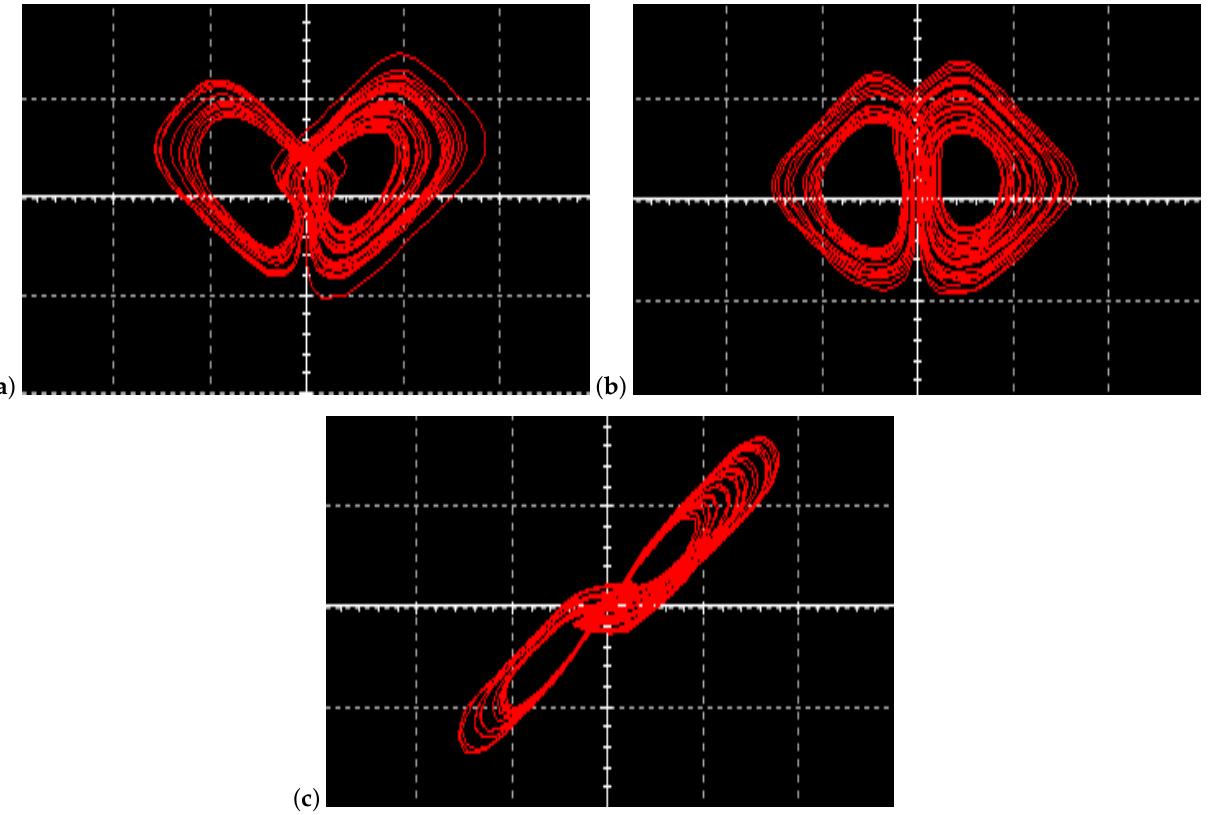
Figure 16. Chaotic behaviors of implemented electronic circuit with initial conditions ( X ( 0 ) , Y ( 0 ) , Z ( 0 )) = ( 1 V ,1 V ,1 V ) in ( a ) X − Z , ( b ) Y − Z , and ( c ) X − Y